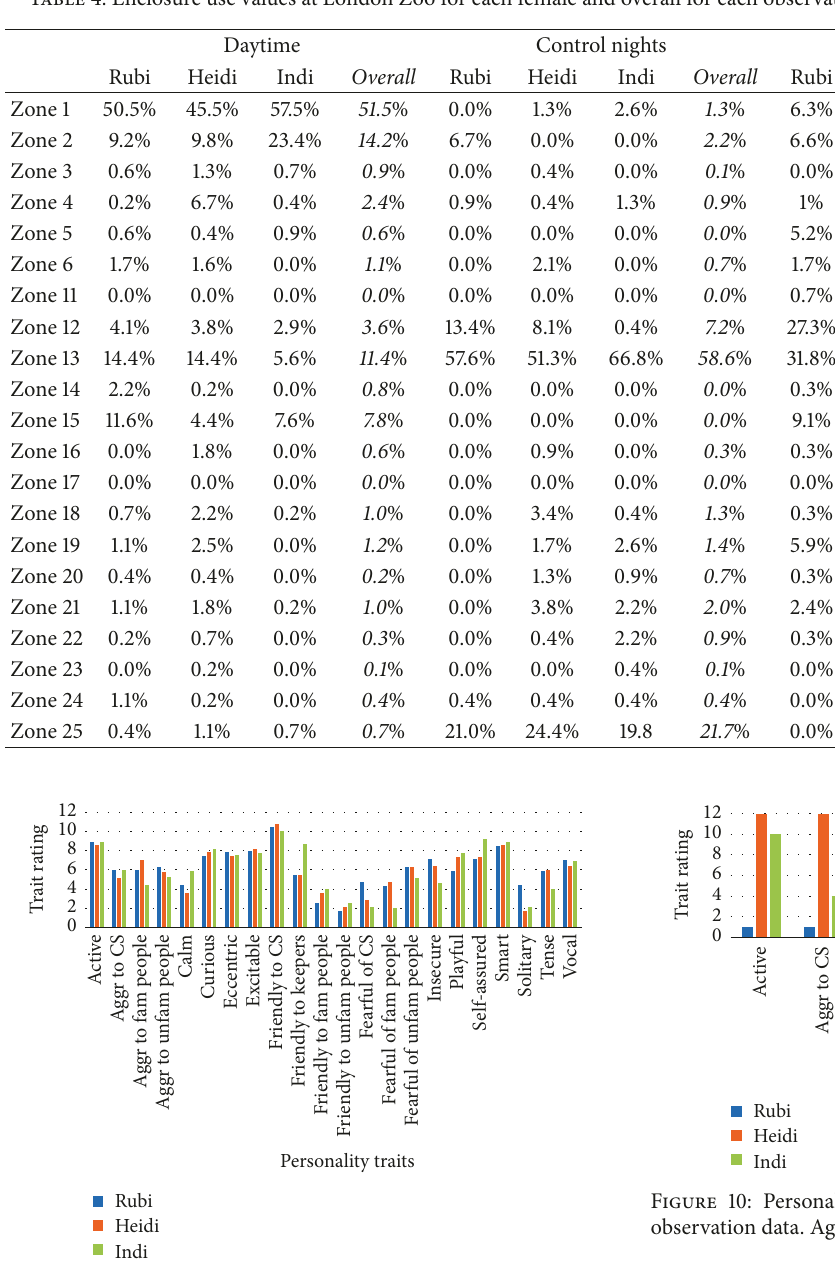
All observation